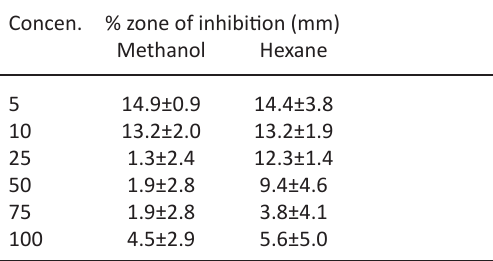
Table 4. Mean and Standard deviation for methanol and hexane extracts for M. oleifera at 100%, 75%, 50%, 25%, 10% and 5% concentration against S. aureus